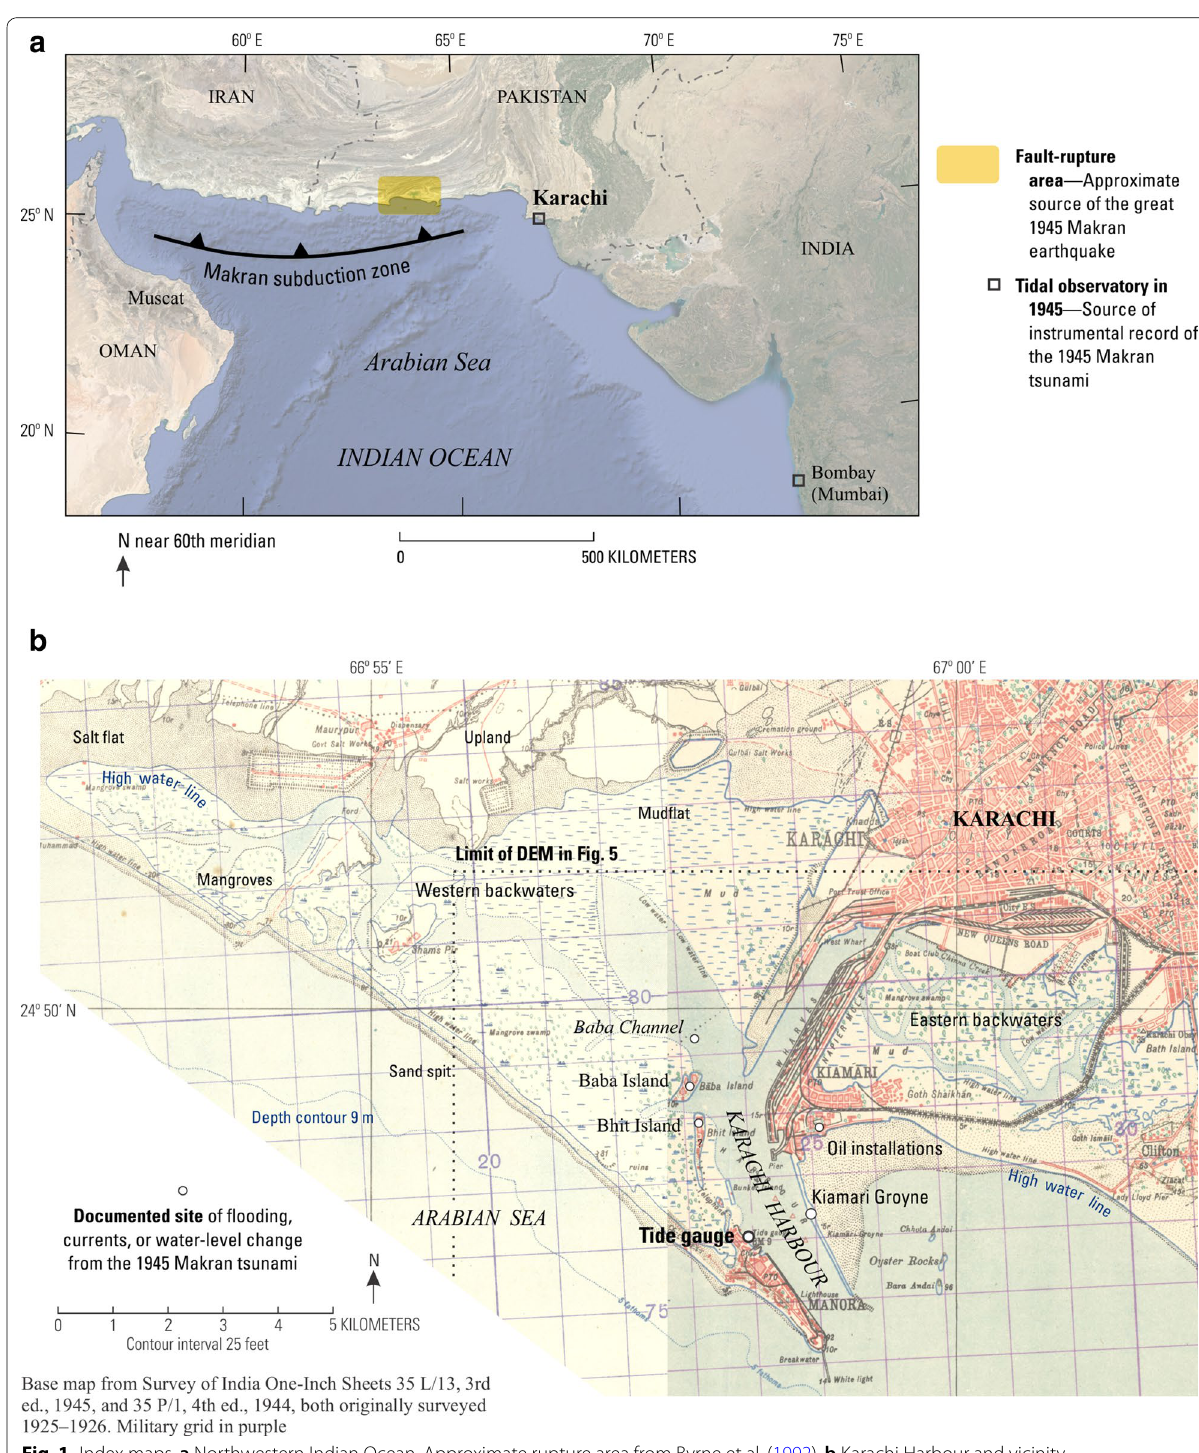
Fig. 1 Index maps. a Northwestern Indian Ocean. Approximate rupture area from Byrne et al. (1992). b Karachi Harbour and